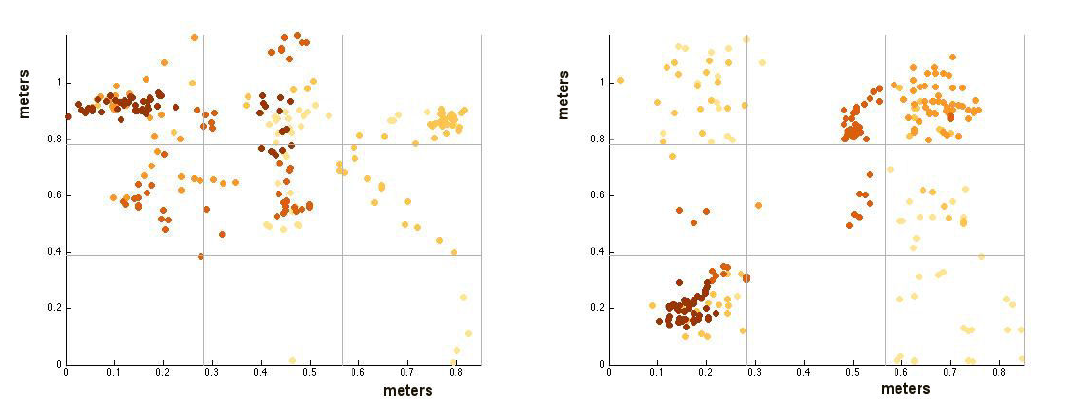
Figure 11. The computed hit map for Child #3, Sessions A (left) and B